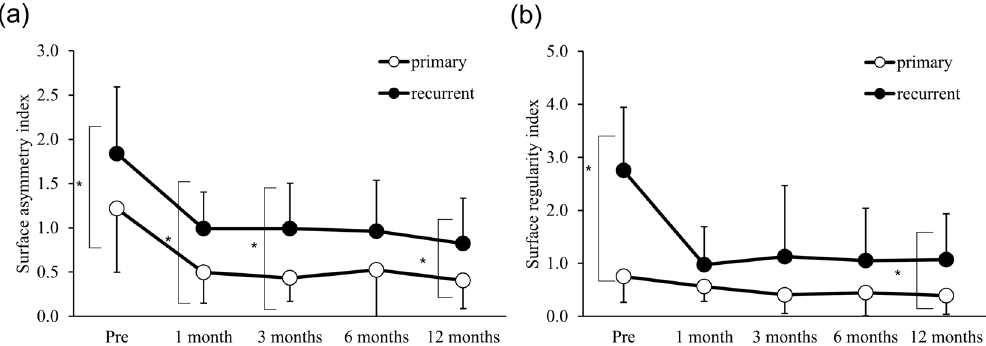
Figure 2. Surface asymmetry index (SAI) and surface regularity index (SRI) of grade 3 pterygium. ( a ) Preoperative and postoperative SAI of grade 3 pterygium. There was significant difference between primary and recurrent pterygium before and at 1, 3, and 12 months after surgery ( * :p = 0.04, 0.01, 0.01, and 0.02, respectively). Compared to the preoperative value, the SAI in primary pterygium significantly decreased at 1, 3, 6, and 12 months (p = 0.005, 0.003, 0.007, and 0.003, respectively) and the SAI in recurrent pterygium significantly decreased at 1, 3, 6, and 12 months (0.01, 0.01, 0.01, and 0.004, respectively). ( b ) Preoperative and postoperative SRI of grade 3 pterygium. There was a significant difference between primary and recurrent pterygium before and at 12 months after surgery ( * p < 0.001 and p = 0.02, respectively). Compared to the preoperative values, the SRI in primary pterygium significantly decreased at 3 months (p = 0.03) and the SRI in recurrent pterygium significantly decreased at 1, 3, 6, and 12 months (p = 0.005, 0.004, < 0.001, and 0.002,